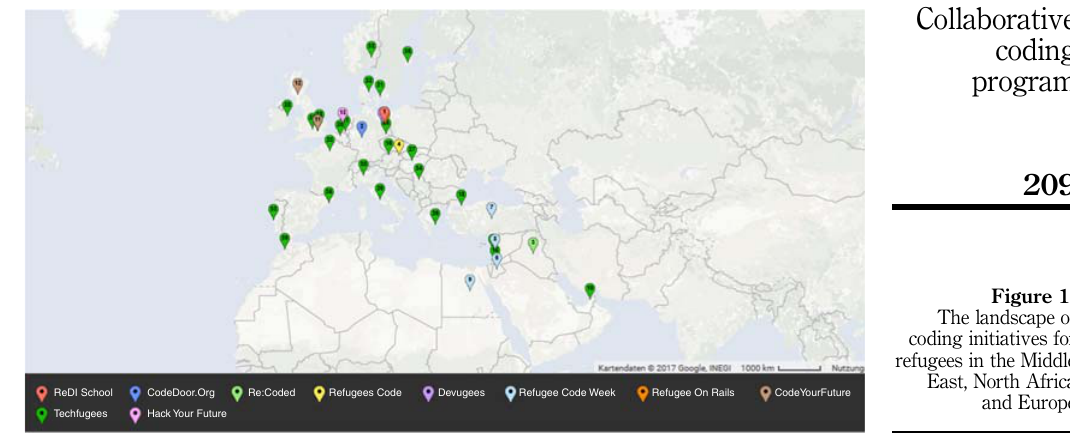
Figure 1. The landscape of coding initiatives for refugees in the Middle East, North Africa and